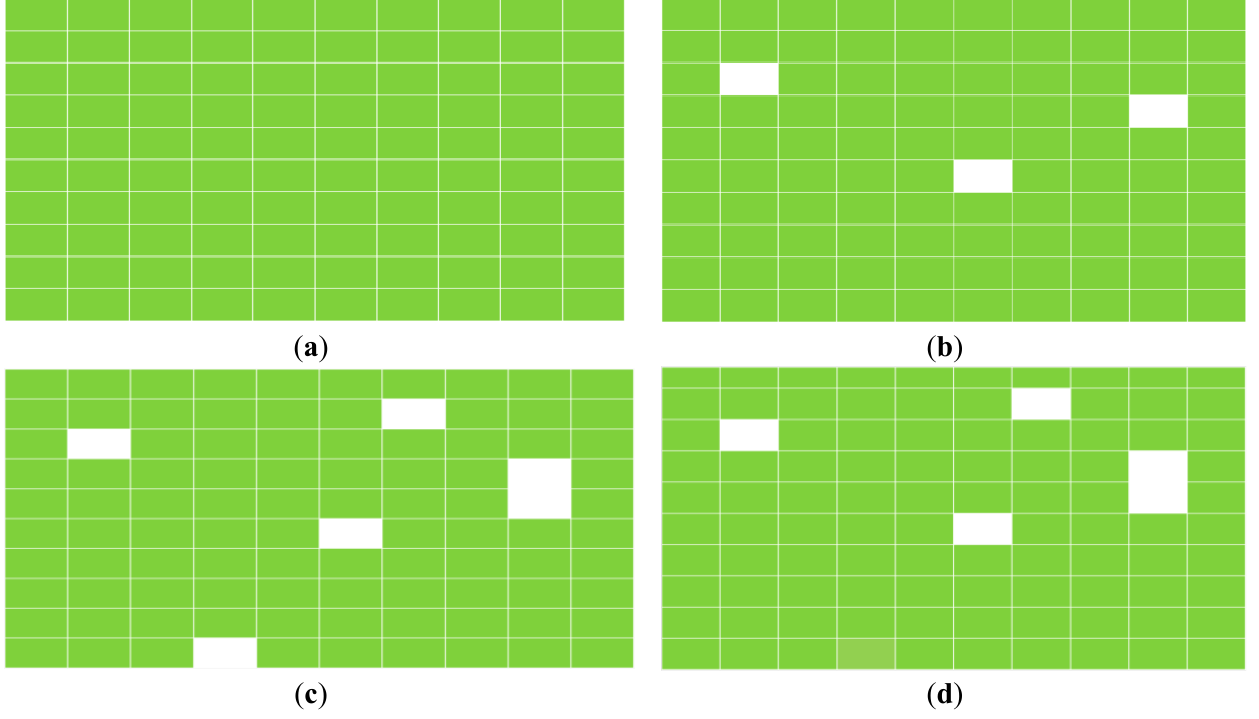
Figure 1. Example showing the difficulty of identifying who should receive benefits relating to the reduction of deforestation within a large geographical area. ( a ) Year 1: Region has 100 intact forest parcels; ( b ) Year 2: before REDD+ 3 parcels are cleared: rate of loss 3%; ( c ) Year 3: without REDD+ Continuing at 3% loss, 6 parcels would be cleared by the following year; ( d ) Year 3: with REDD+ However, with REDD+, the rate of loss is reduced to 2%. One parcel is “saved”, but it is impossible to determine which